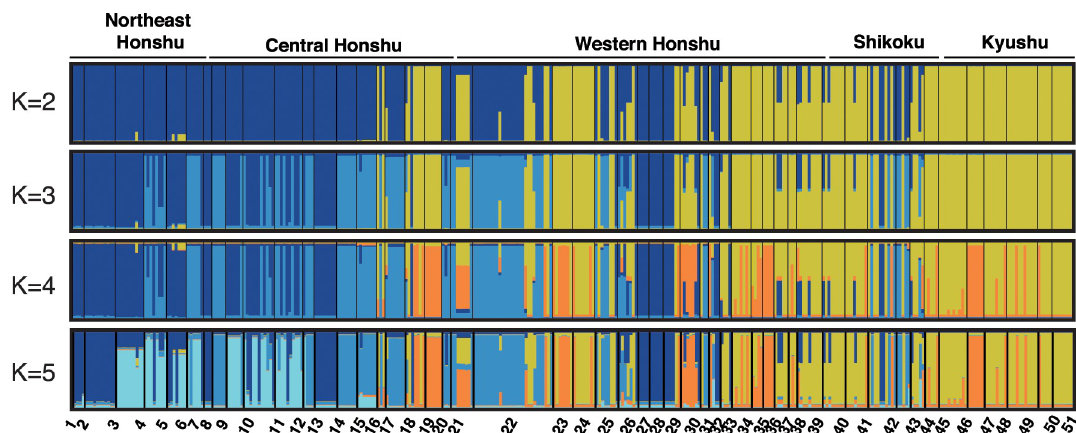
Fig 1. Results of InStruct analysis for full dataset. The proportion of the membership coefficient of 352 individuals in the 51 populations for each of the inferred clusters for K = 2–5 defined using Bayesian clustering in InStruct analysis. Each individual is shown as a column, and populations are separated from each other by a bold black line. Numerals at the bottom indicate population